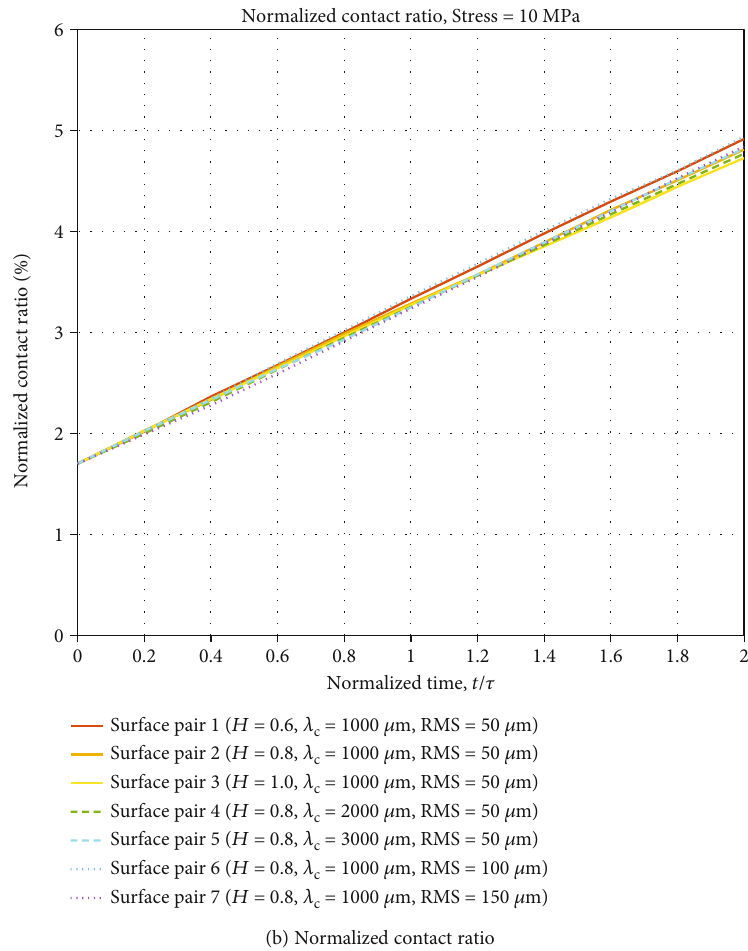
Figure 20: Normalized mean aperture and contact ratio of the seven surface pairs (shown in Table 3). The time t is normalized by τ . (a) Normalized mean aperture changing with time for the seven surface pairs; (b) normalized contact ratio changing with time for the seven surface pairs. The formulae for normalized mean aperture and normalized contact ratio are shown in Equations (37) and (38),